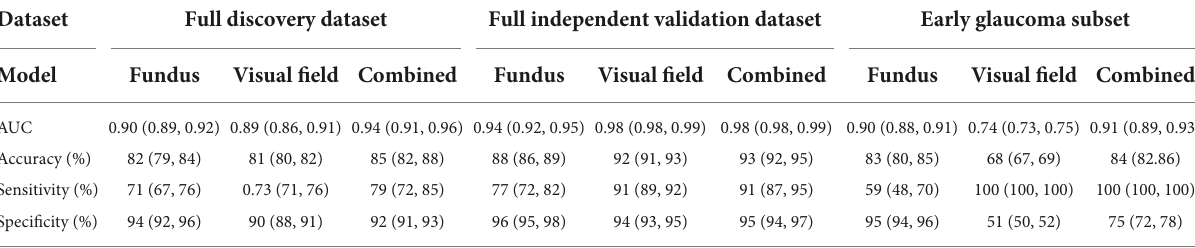
TABLE 2 Average value of evaluation metrics of different probabilistic deep learning models in discriminating normal eyes from eyes with glaucoma.